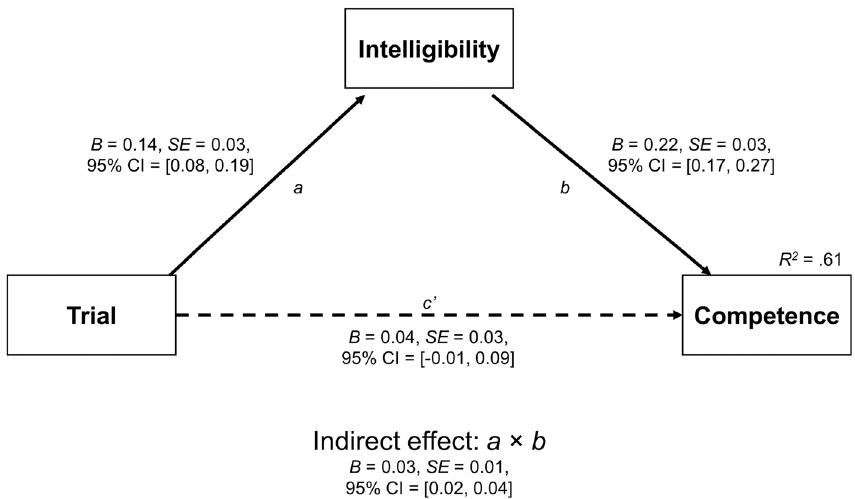
Figure 4. Indirect effect of Trial on competence via intelligibility. Trial effects are scaled to 10 trials. Solid lines represent significant paths while dashed lines represent non-significant